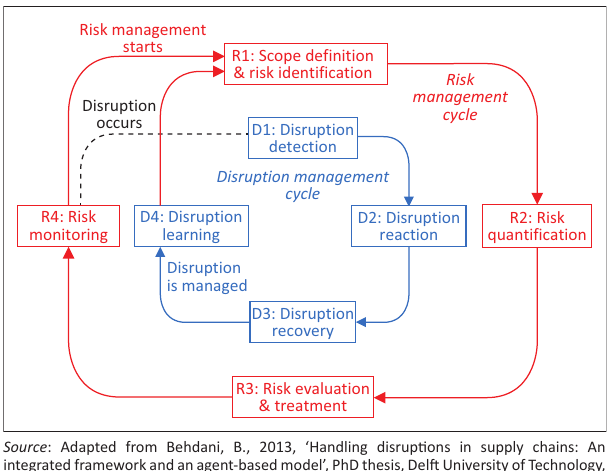
FIGURE 1: Integrated framework for managing disruption risks in supply